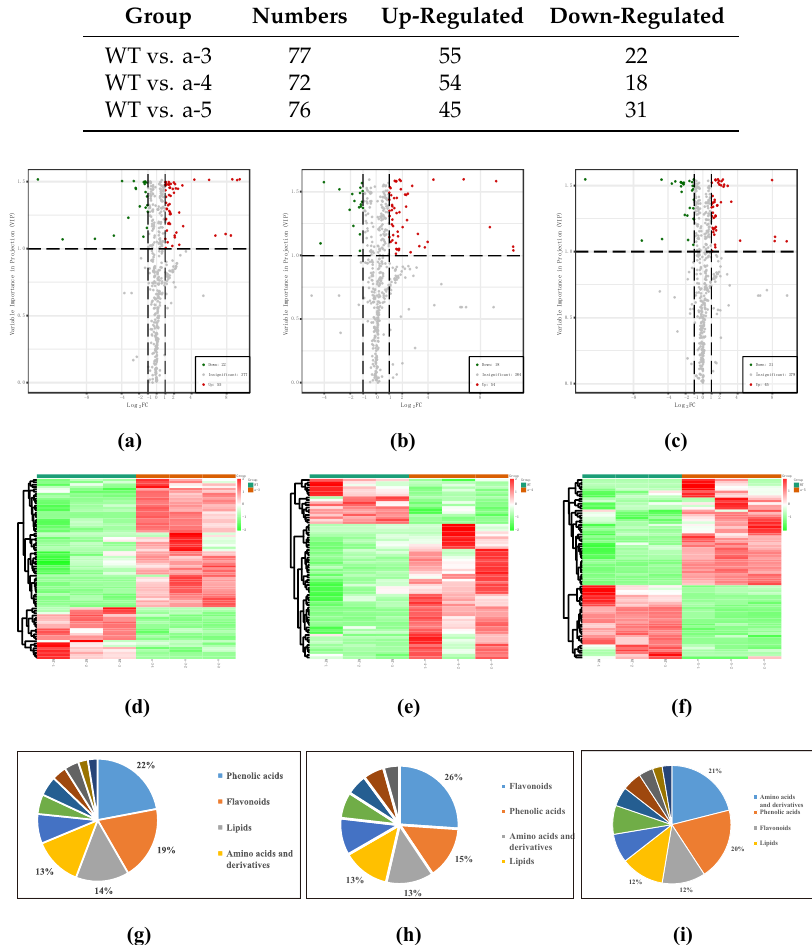
Table 1. Summary of di ff erentially accumulated metabolites (DAMs) among WT, a-3, a-4, and a-5.